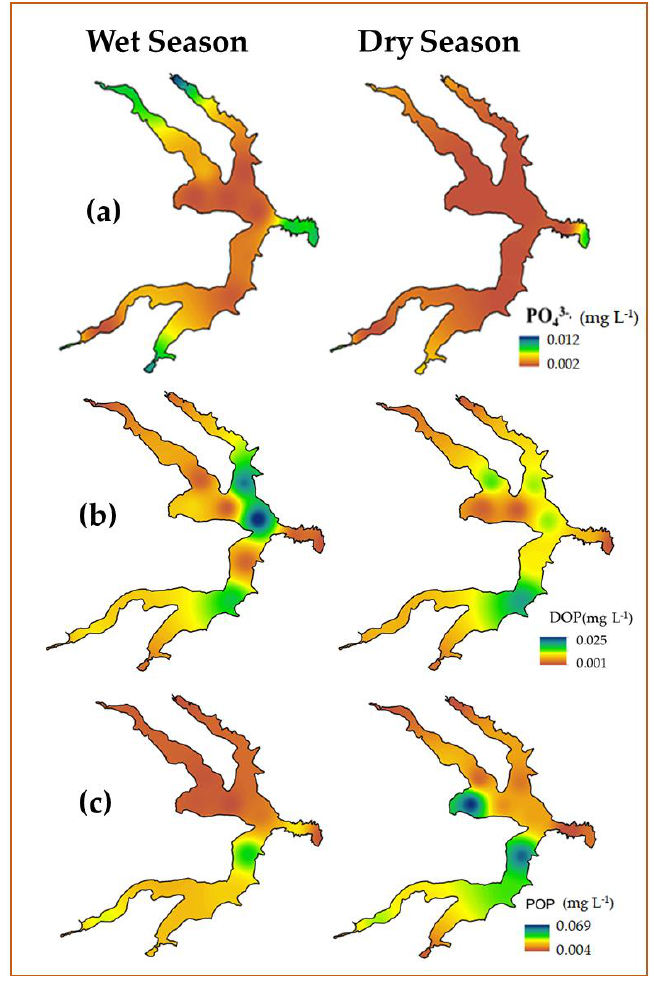
Figure 11. Spatial distribution of water quality variables: ( a ) PO 43 - , ( b ) DOP, and ( c ) POP for wet and dry season.